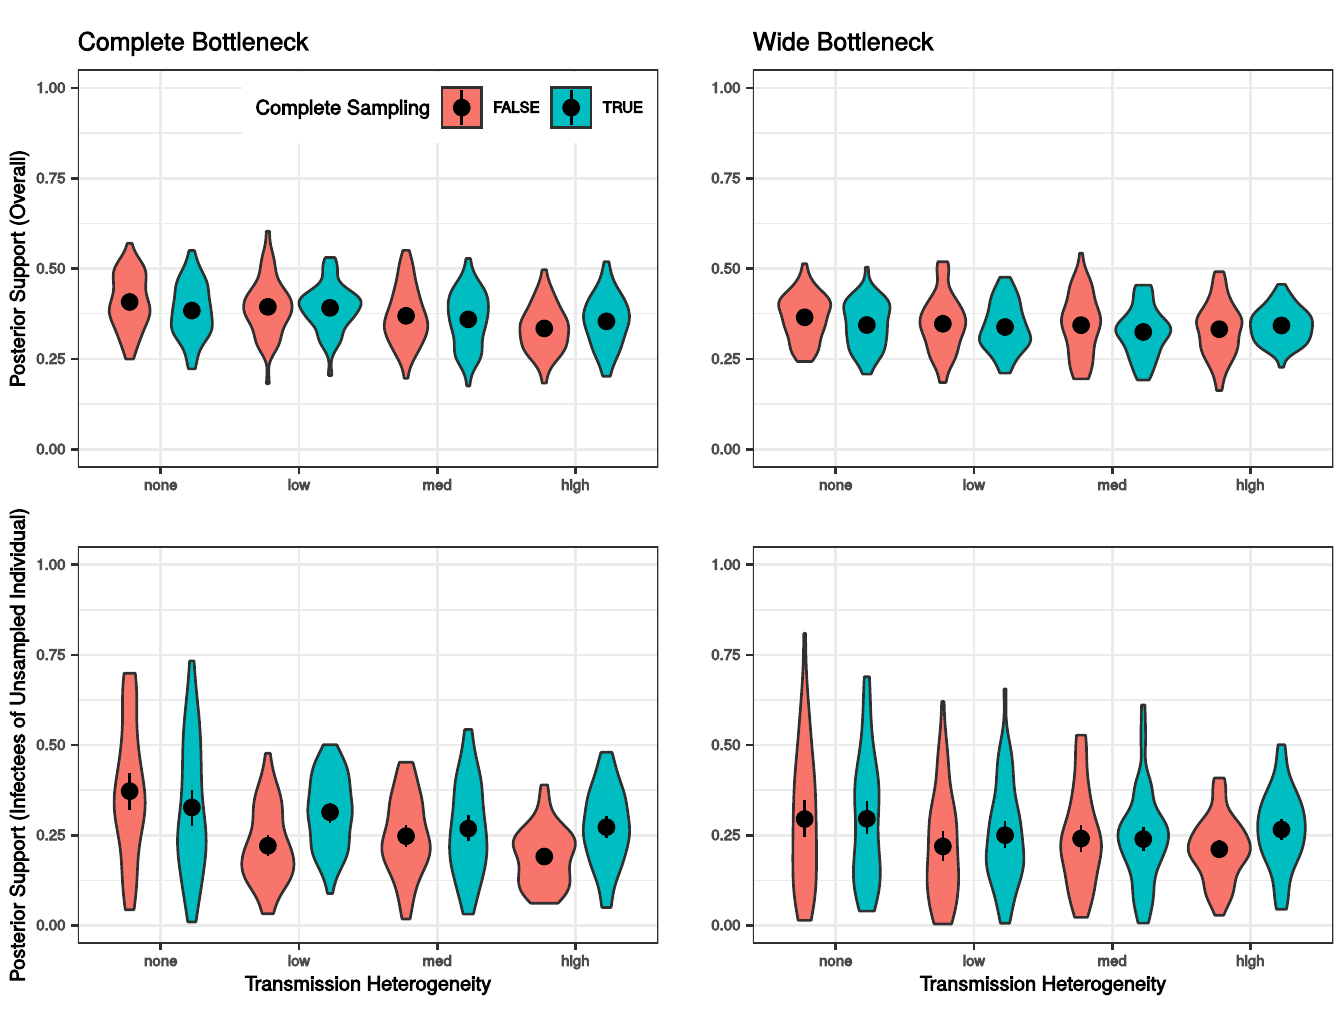
Fig 6. The Effect of Incomplete Sampling. Violins show the distribution of means of the posterior probability for true infectors (sources), or the true infectors’ infectors if the true infector is unsampled, with the point and line segment in each violin representing the mean and 95% bootstrapped interval for the estimate of the mean. (Top Row) Overall model performance. (Bottom Row) Model performance for the individuals infected by the unsampled